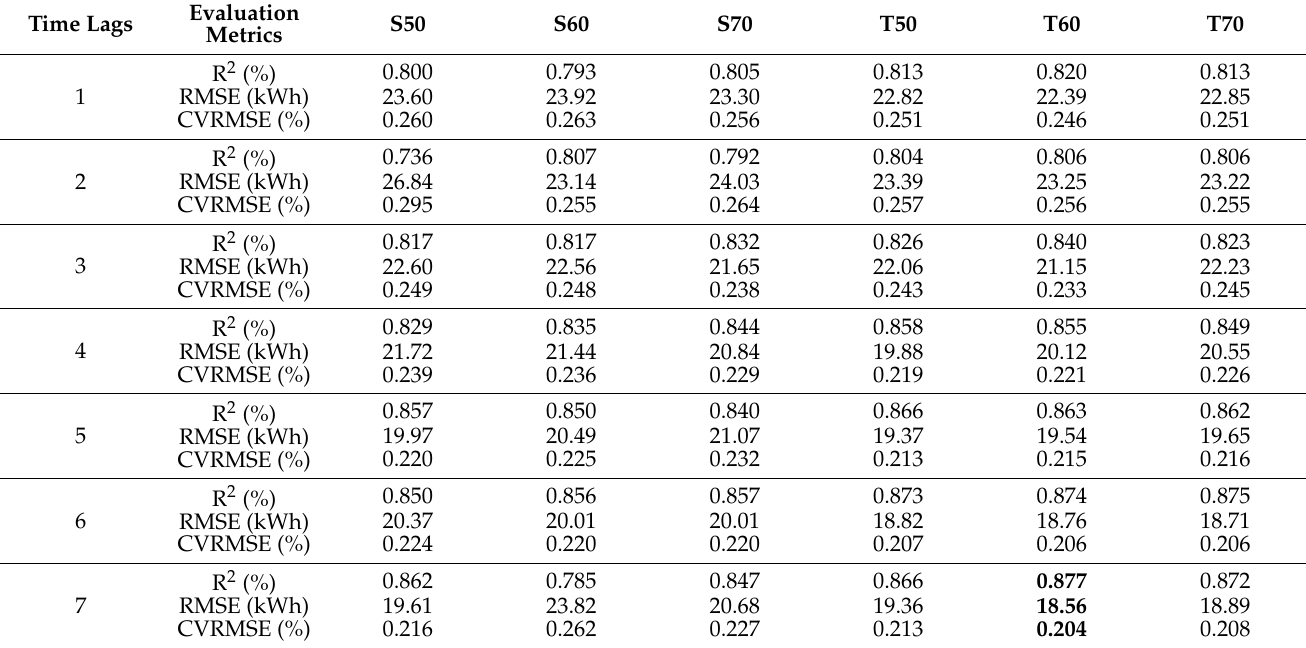
Table 5. Performance in the metrics evaluated when forecasting the energy consumption of the HVAC, using different time lags and HPs, applying the C2